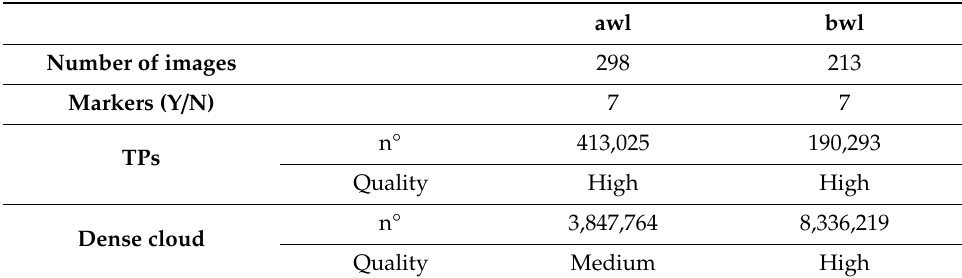
Table 5. Elaboration parameters of the seawall at Lazzaretto.